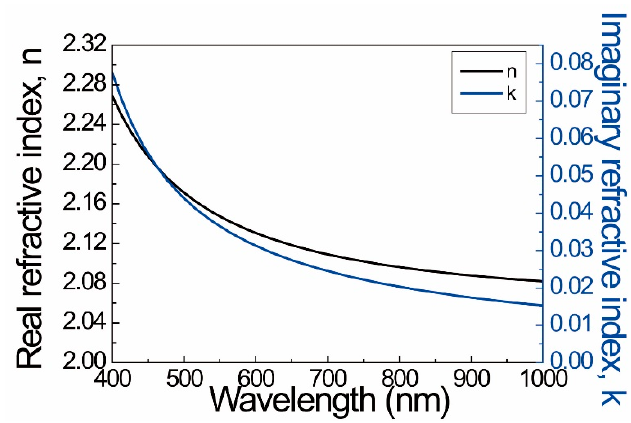
Figure A1. The experimentally measured refractive index (real: black; imaginary: blue) of the UC material, Er 3+ -doped KNbO 3 .